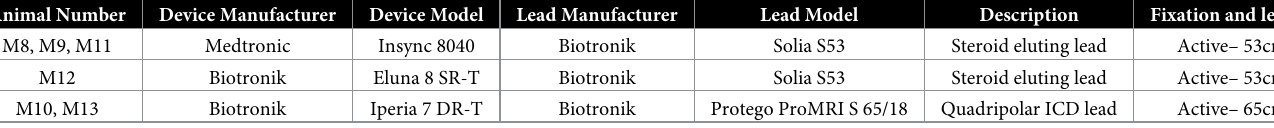
Table 1. Manufacturer and model details relating to pacemaker devices and leads. Animal